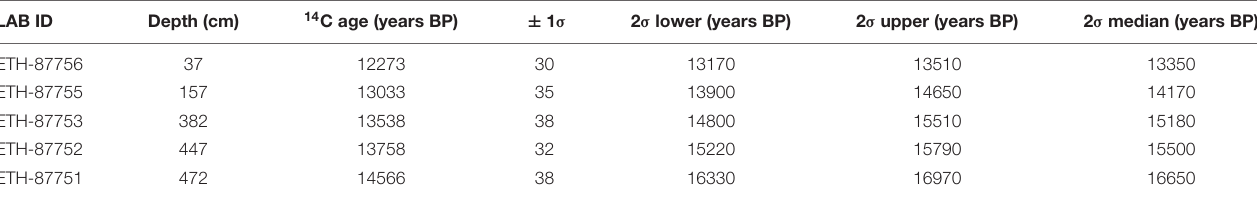
TABLE 2 | Radiocarbon ages of epibenthic foraminifera (species selected: Cibicides lobatulus , Cibicides refulgens and Discanomalina coronata ). LAB ID